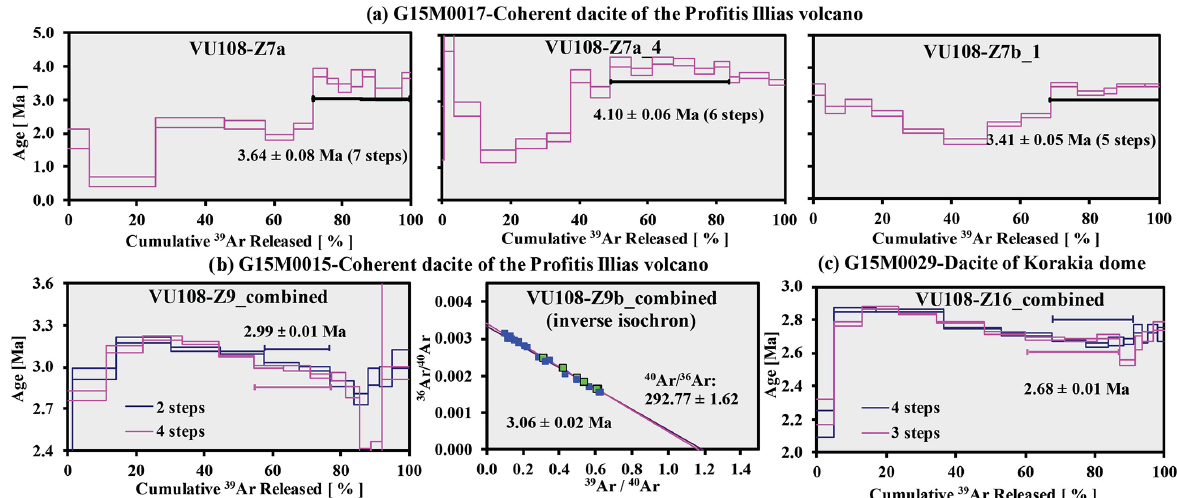
Figure 6. Groundmass 40 Ar / 39 Ar plateau or inverse isochron ages for samples G15M0017 (a) , G15M0015 (b) and G15M0029 (c) . Individ- ual steps and final age calculation are reported with 1 σ errors. The Profitis Illias volcano (a,b) and dacitic Korakia dome (c) are located in the south-western and north-eastern parts of the Milos VF, respectively (Fig. 2). See the individual steps of samples G15M0015 and G15M0029 in Supplement file